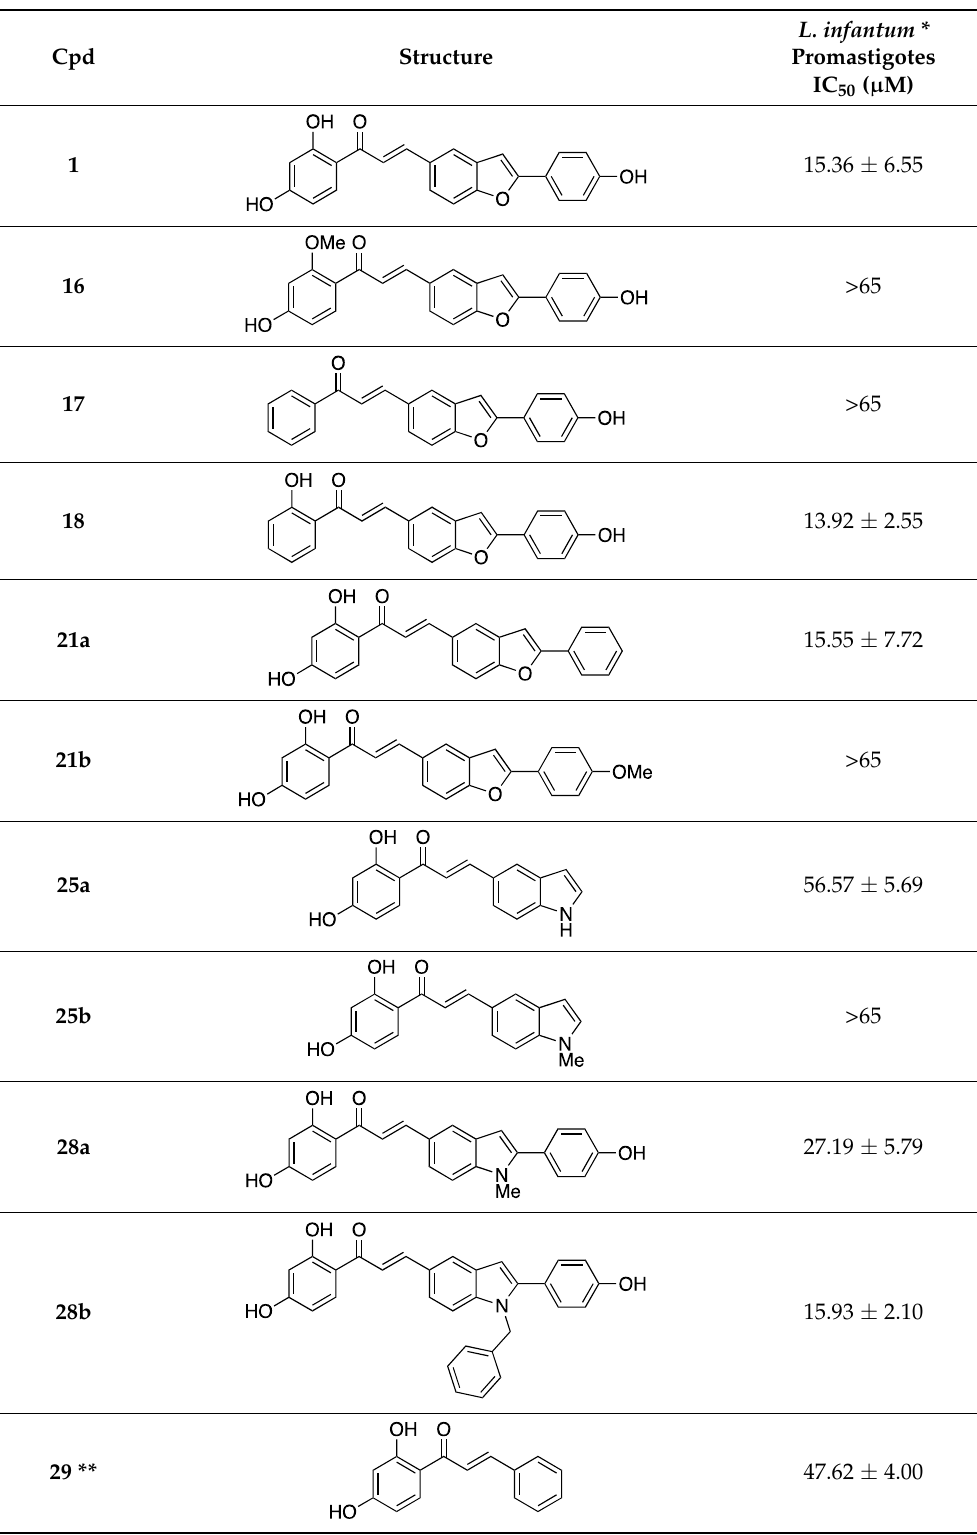
Table 2. Activity of compounds 1 , 16 – 18 , 21a , b , 25a , b , 28a , b , 29 and of reference compound amphotericin B against L. infantum promastigotes.